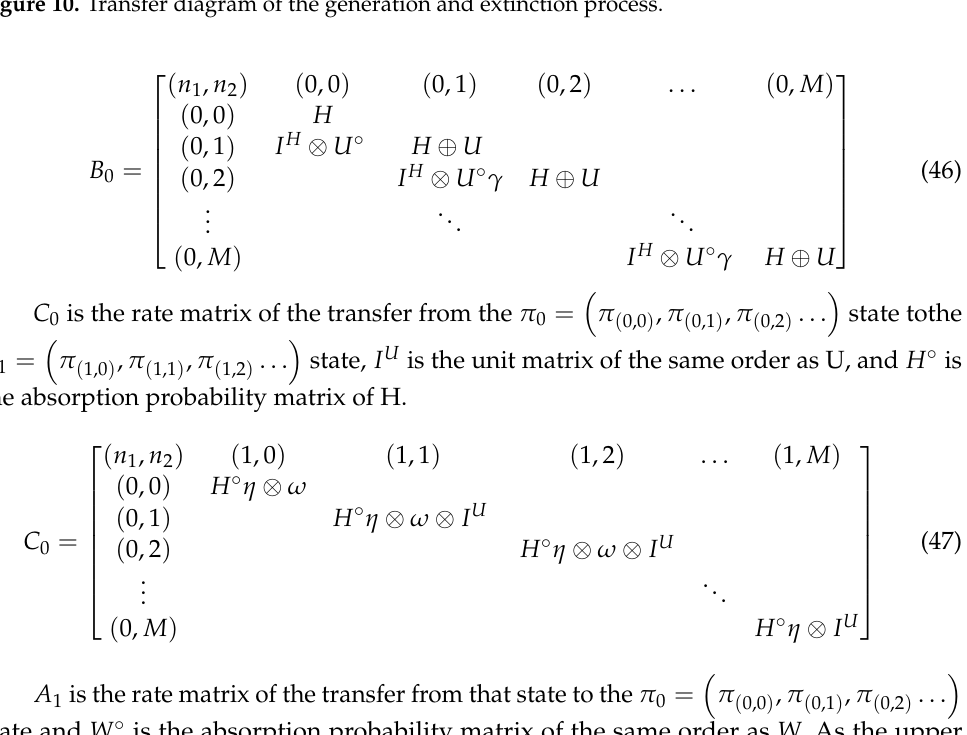
Figure 10. Transfer diagram of the generation and extinction process.